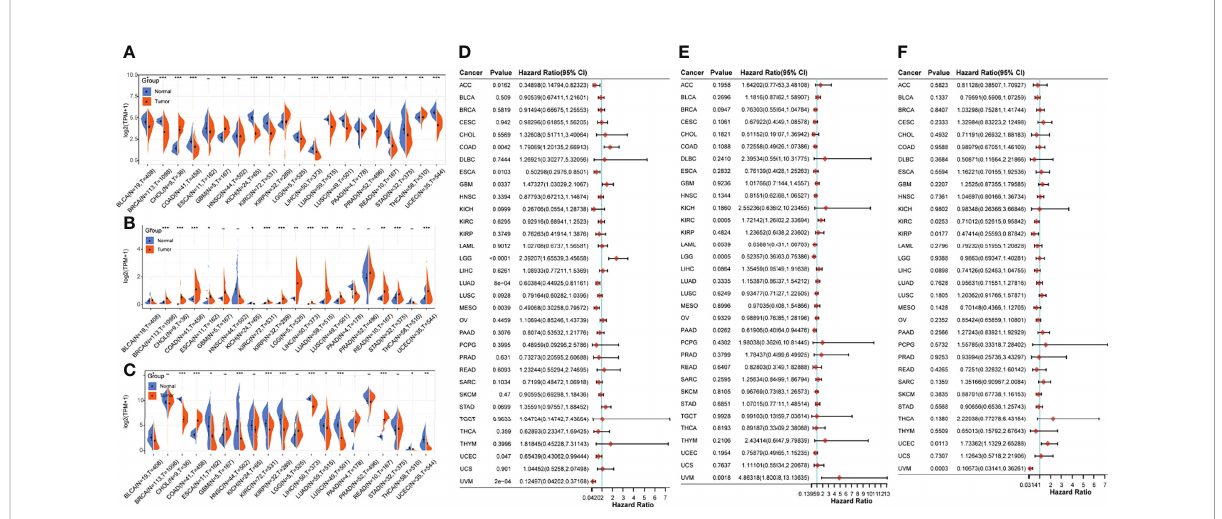
FIGURE 7 Pan-cancer analysis of core genes. (A – C) Expressions of AZGP1, SLCO5A1, and CTF1 in different cancers and paracancerous tissues; (D – F) : prognostic survival effects of AZGP1, SLCO5A1, and CTF1 in different cancers; * indicates p < 0.05, ** indicates p < 0.01, and *** indicates p < 0.001, with p < 0.05 being signi fi